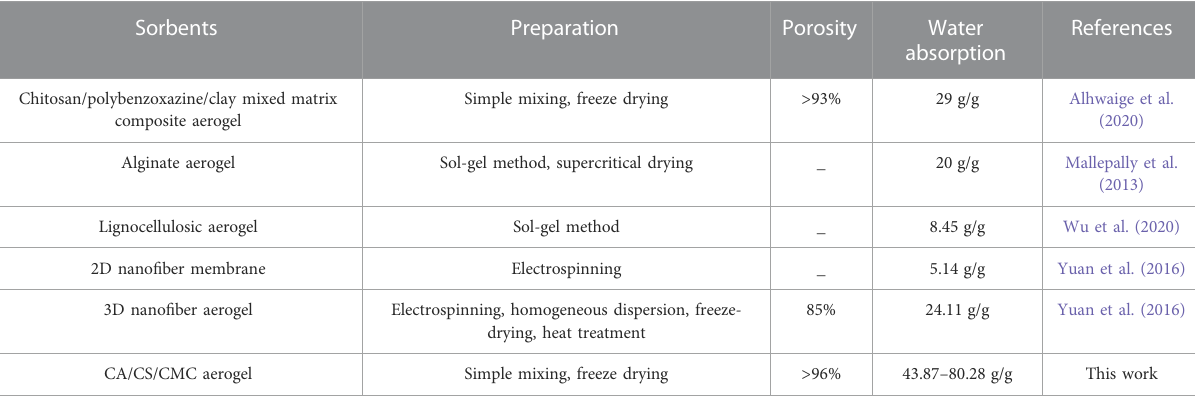
TABLE 1 Comparison of the as-prepared aerogel and several reported water